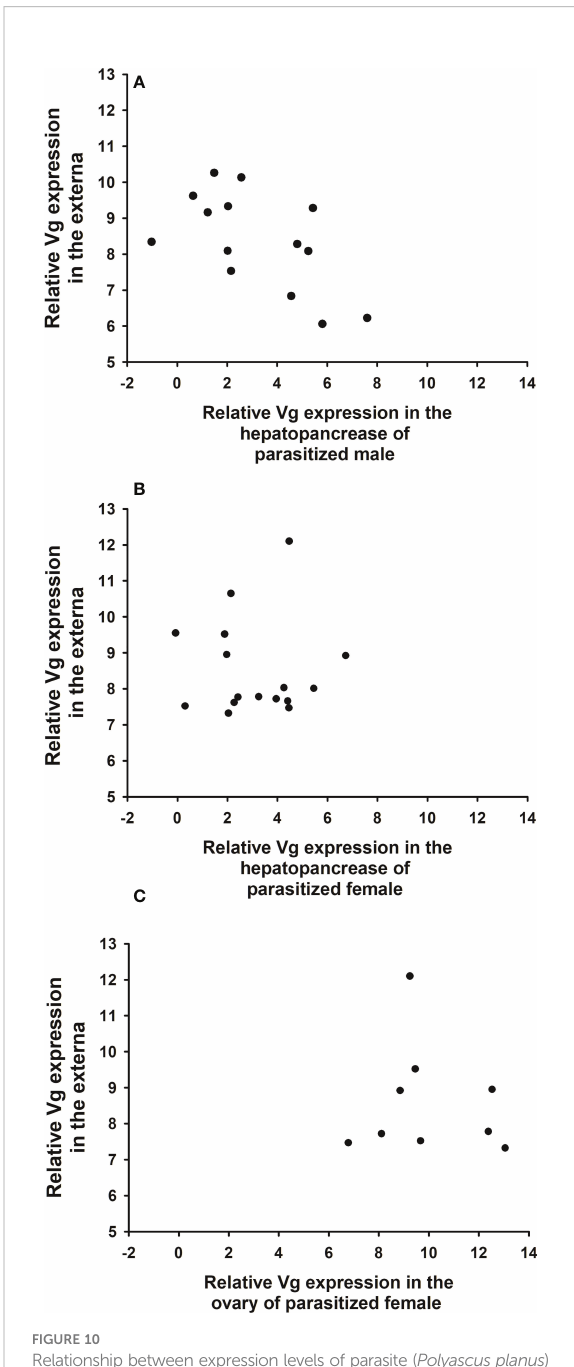
FIGURE 10 Relationship between expression levels of parasite ( Polyascus planus ) and host ( Metopograpsus thukuhar ) vitellogenin. Relative expression levels of parasite Vg are plotted against those of host Vg in the hepatopancreas of parasitized (A) male, (B) female, and (C) the ovary of parasitized female. Sample size for (A – C) is 14, 16, and 9, respectively. Correlation analysis shows that only the expression levels in male hepatopancreas is signi fi cantly (negatively) correlated with those in the externa ( r = -0.595; p =